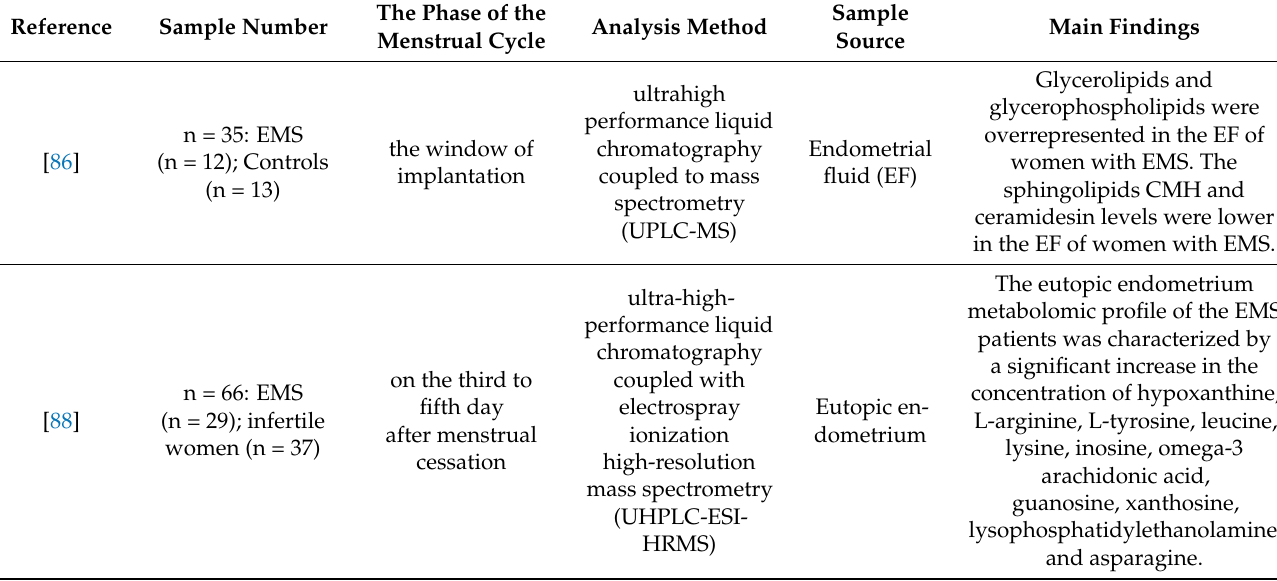
Table 2. Characteristics of endometrium metabolomic studies in patients with